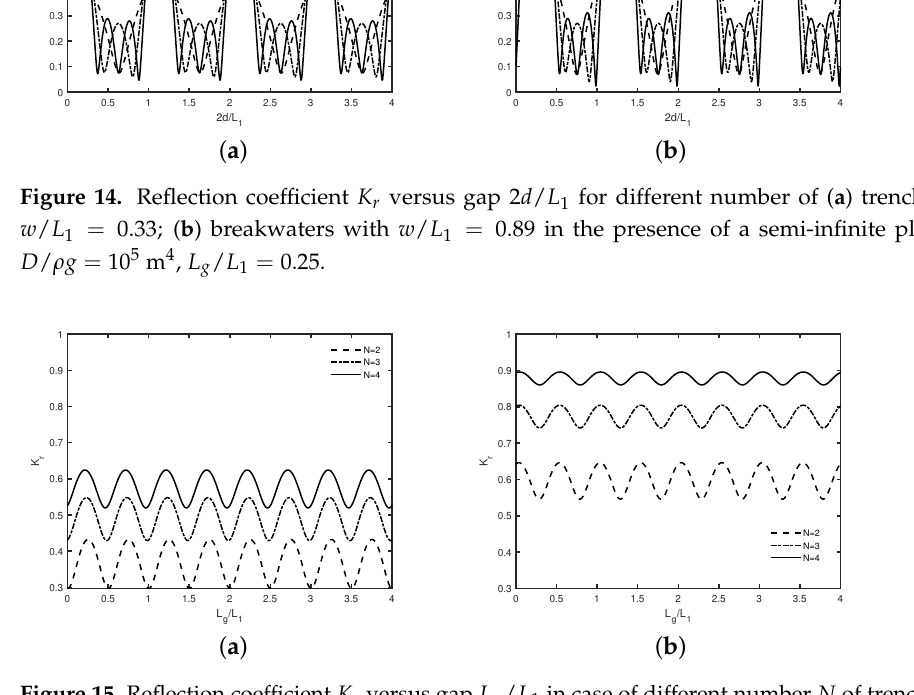
Figure 15. Reflection coefficient K r versus gap L g / L 1 in case of different number N of trenches with ( a ) w / L 1 = 0.33, d / L 1 = 0.61, and breakwaters with ( b ) w / L 1 = 0.89, d / L 1 = 1.37 in the presence of the semi-infinite plate with D / ρ g = 10 5 m 4